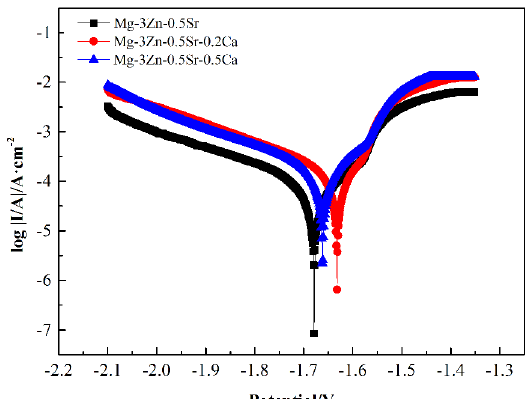
Figure 4. The electrochemical impedance spectroscopy (EIS) plot of Mg-3Zn-0.5Sr-xCa alloy samples in the SBF